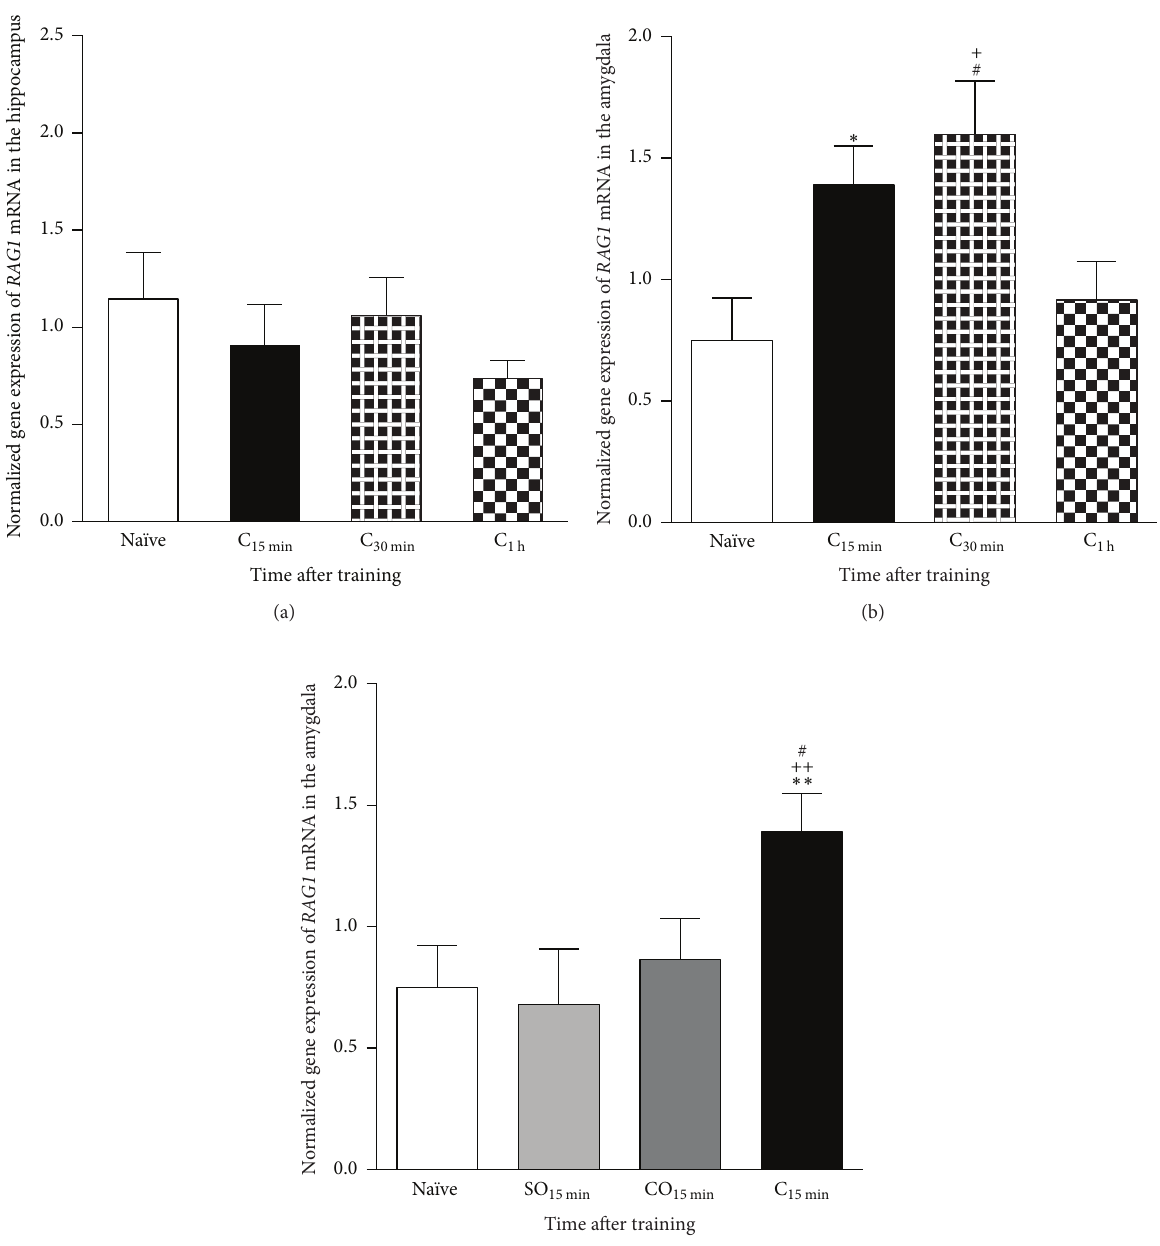
Figure 1: Context fear conditioning induced upregulation of RAG1 mRNA in the amygdala. RAG1 mRNA levels were measured in the hippocampus and the amygdala on a time course at 15 min, 30 min, and 1h after conditioning. (a) Normalized mRNA data showed no significant differences when examining hippocampal RAG1 mRNA Na¨ıve (N) or the conditioned (C) groups sacrificed at 15, 30, or 60 min after training. (b) In contrast, context fear conditioning results in a significant, rapid, and transient induction in RAG1 mRNA levels in the amygdala (Na¨ıve versus C15min, ∗ 𝑃 < 0.05 ; Na¨ıve versus C30 min, # 𝑃 < 0.05 ; Na¨ıve versus C60min, 𝑃 > 0.05 ; C60min versus C30min, + 𝑃 < 0.05 ; and C60min versus C15min, 𝑃 > 0.05 ). (c) We sacrificed animals from the conditioned (C), CO, or SO groups 15min after their respective associative or nonassociative training. Normalized expression confirmed the significant induction at 15min of amygdalar RAG1 mRNA after context fear conditioning compared to Na¨ıve, CO, and SO groups and showed no statistical difference between Na¨ıve, CO, or SO controls (SO15min versus C15min, # 𝑃 < 0.05 ; SO15 min versus Naive, 𝑃 > 0.05 ; SO15 min versus CO15min, 𝑃 > 0.05 ; CO15min versus C15min, ++ 𝑃 < 0.01 ; CO15min versus Naive, 𝑃 > 0.05 ; and Na¨ıve versus C15min ∗∗ 𝑃 < 0.01